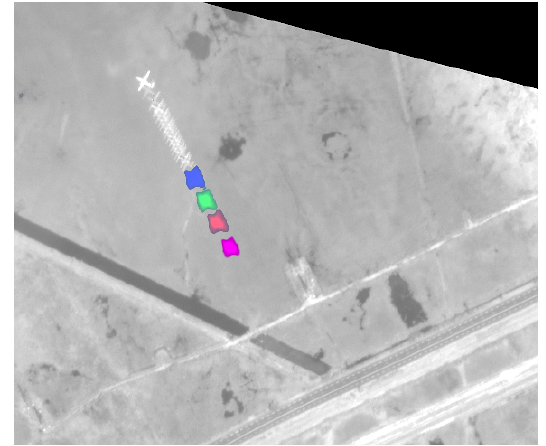
Figure 12: Example of a Skybox image showing a moving plane in PAN, blue, green, red and NIR channel (2014-08-09, detector 3, image 6)